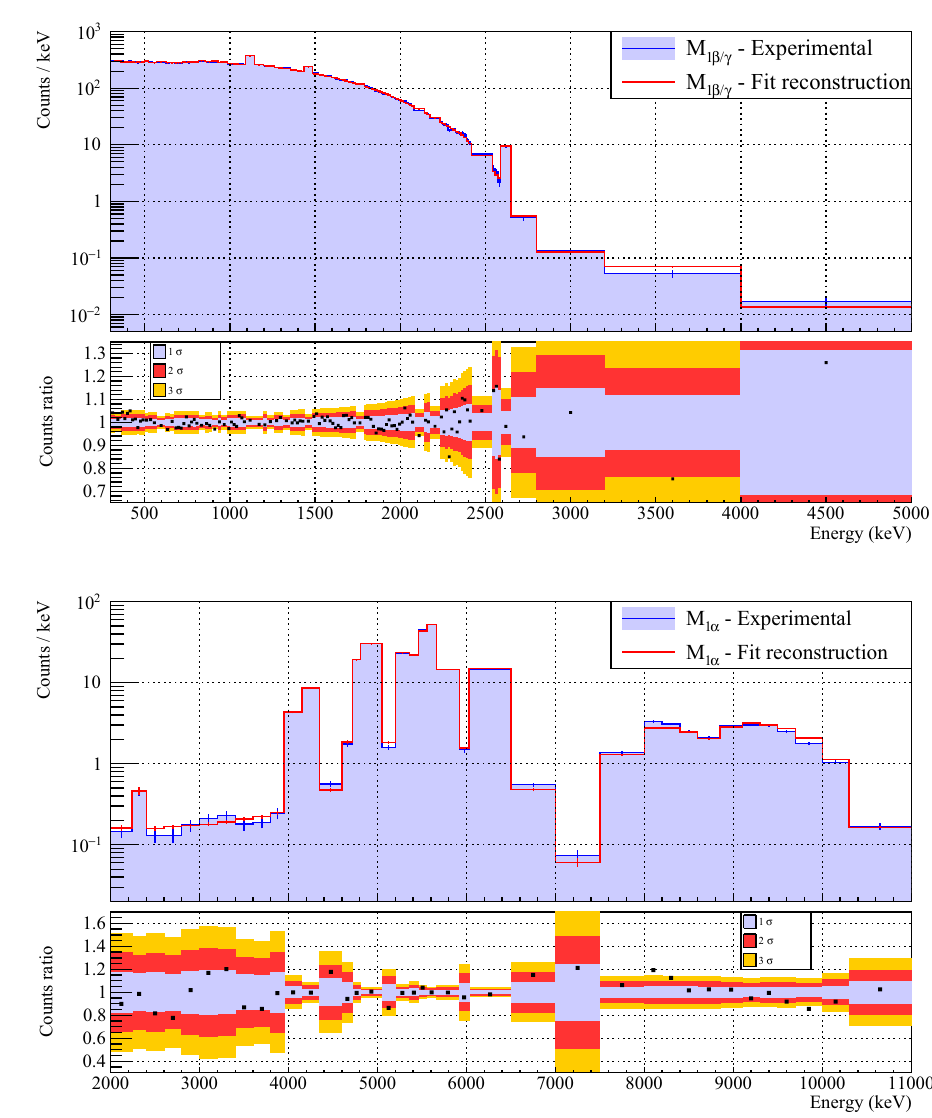
Fig. 5 Top : comparison between experimental M 1 β/γ spectrum and fit reconstruction. The lower panel shows the bin by bin ratios between counts in the experimental spectrum over counts in the reconstructed one; the corresponding uncertainties at 1, 2, 3 σ are shown as colored bands centered at 1. Bottom : same as top for M 1 α